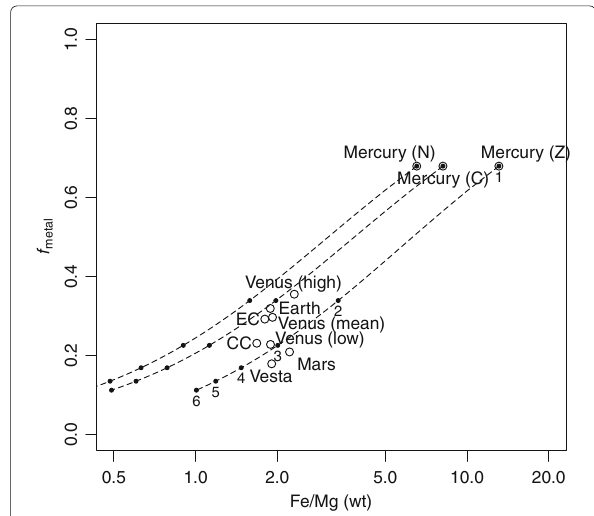
Fig. 3 Metal weight fraction ( f metal ) versus planetary Fe/Mg mass ratio for various rocky bodies and chondritic meteorite classes (EC, enstatite; CC, carbonaceous). Bulk Mercury estimates from Nittler et al. (2018), Chabot et al. (2014), and Zolotov et al. (2013). Mercury is a singular outlier from the cluster defined by the other objects. Dashed line is trend from silicate added to Mercury with the composition of its bulk silicate (Table 3); points on line show total body mass in units of M (cid:2) . An original mass 2–4 × M (cid:2) would put it within the rocky body cluster. Data are from Fegley (2014), Dumoulin et al. (2017), McDonough and Sun (1995), Rivoldini et al. (2011), Javoy et al. (2010), and Table